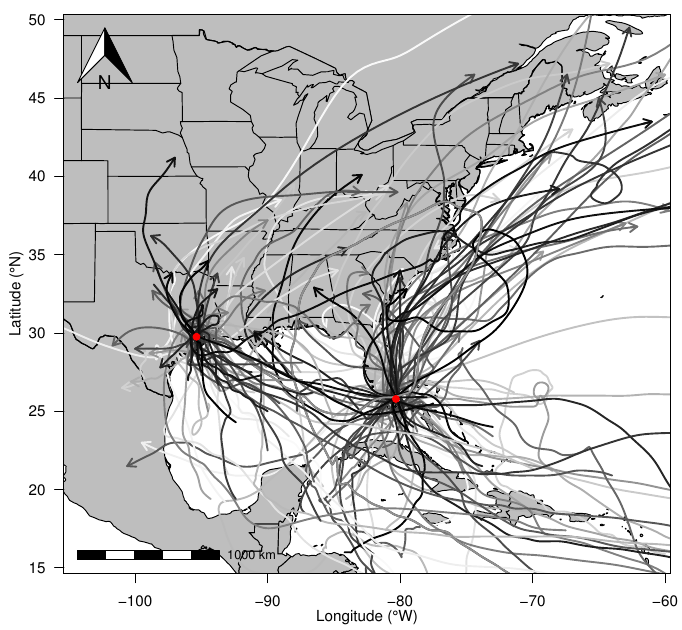
Figure 1. Study Area with tropical cyclones (TCs) used in this study. Both locations are shown with points. Houston, Texas is near the northwest Gulf of Mexico and Miami, Florida faces the Atlantic Ocean. TCs are shaded based on their wind speed intensity at landfall: darker tracks indicate TCs with higher wind